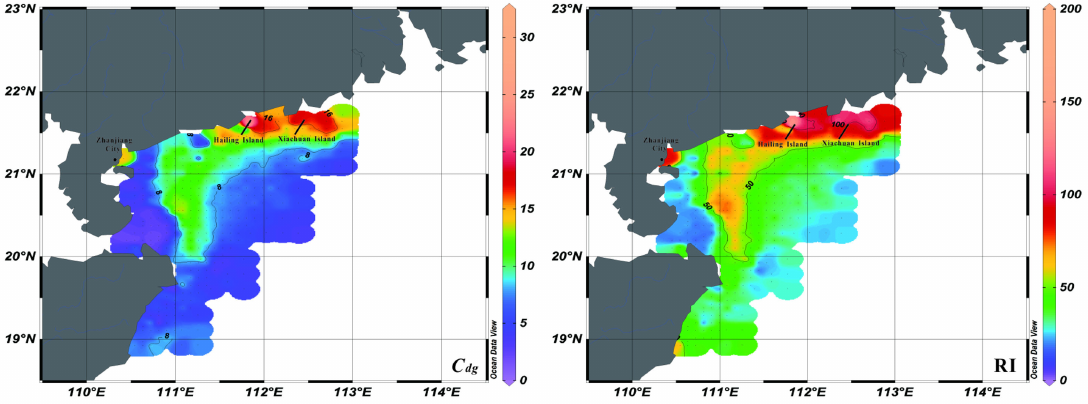
Figure 4. Spatial distribution patterns of the degree of contamination ( C dg ) and potential ecological risk index (RI) for heavy metals in the study